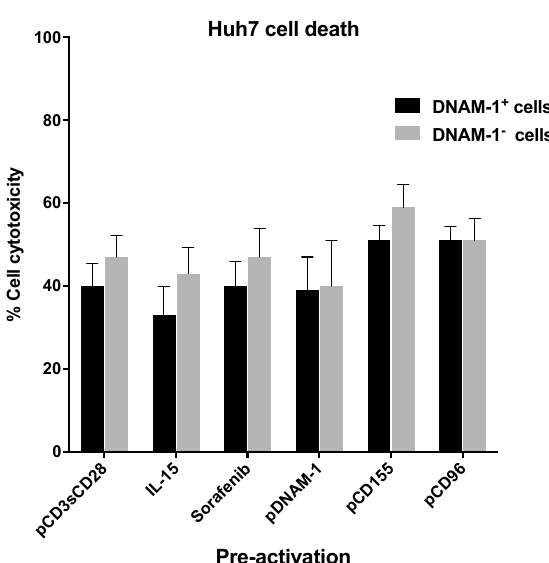
Figure 6. Effects of activated T CD4 + DNAM-1 + and DNAM-1 − cells on cytotoxic response. Top : Human T CD4 + cells were isolated from buffy coat and stimulated with PMA (50 ng/mL) and ionomycin (1 µ g/mL) for 6 h in presence of Brefeldin-A (500 ng/mL) and anti-CD107a antibody. At the end of stimulation cells were fixed, permeabilized, and stained for quantification of CD107a, IFN- γ (gamma), IL-4 and TNF- α (alpha). Bottom : Cytotoxic capacity of effector CD4 − lymphocytes co-cultured with activated T CD4 + DNAM-1 + and DNAM-1 − cells. T CD4 + cells were pre-activated for 72 h before being moved into culture with autologous lymphocytes and Huh7 cells. After 24 h, cytotoxicity was assessed using MTS viability assay. PMA: phorbol myristate acetate, ION: Ionomycin, pCD3: plate-bound anti-CD3, sCD28: soluble anti-CD28, Sora: Sorafenib, pDNAM-1: plate-bound anti-DNAM-1, pCD155: plate-bound anti-CD155, pCD96: plate-bound